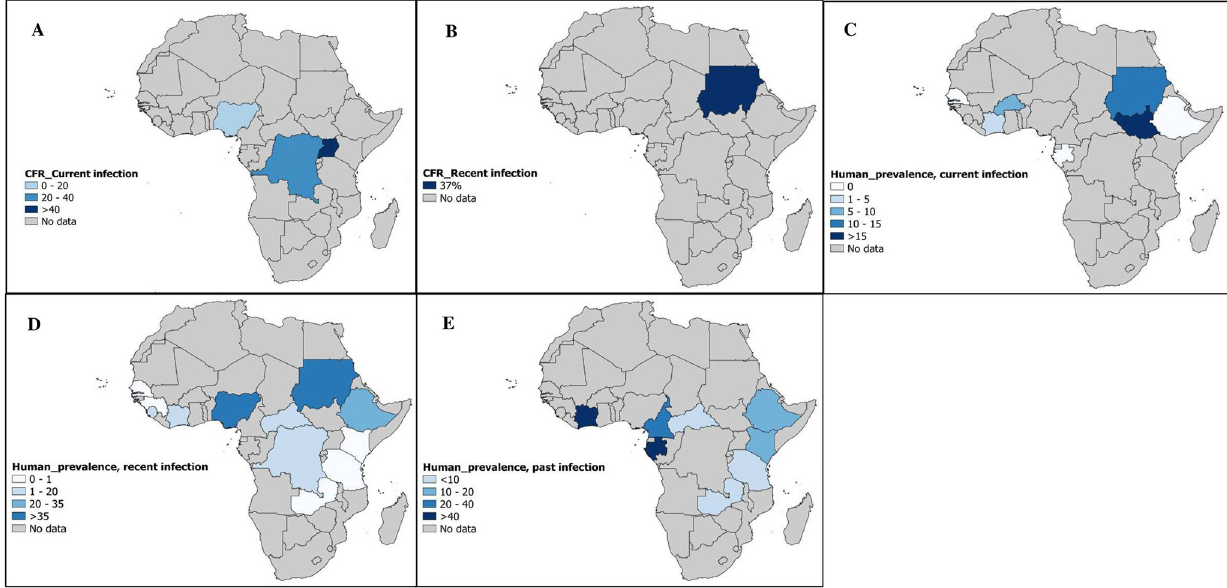
Fig 2. Case fatality rate and prevalence estimate of yellow fever virus in humans in sub-Saharan Africa. The letters (A and B) show the case fatality rate in humans with current and recent yellow fever virus exposures, respectively. The letters (C, D, and E) denote current, recent and past yellow fever virus exposures, respectively. The base map was taken from (https://www.naturalearthdata.com/) and modified with Qgis software.